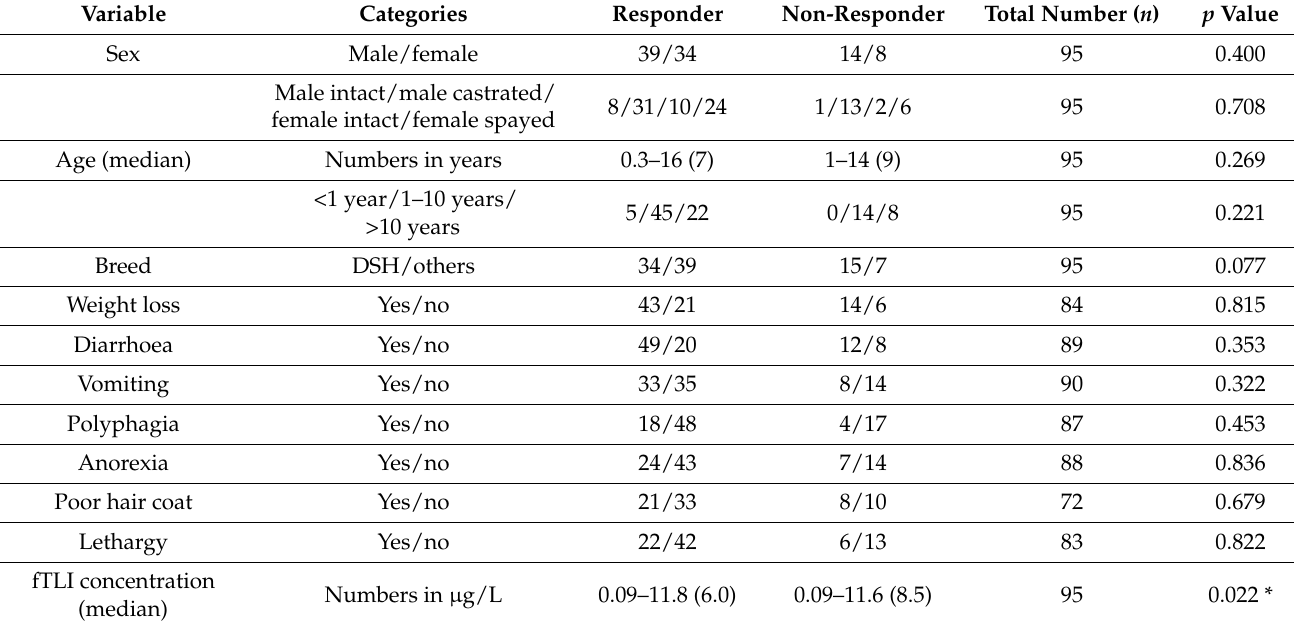
Table 1. Statistical comparison of the signalment, clinical data, and serum fTLI concentration between cats which responded ( n = 73) (groups 1.1a and 2.1a) and those that did not respond ( n = 22) (groups 1.1b and 2.1b) to